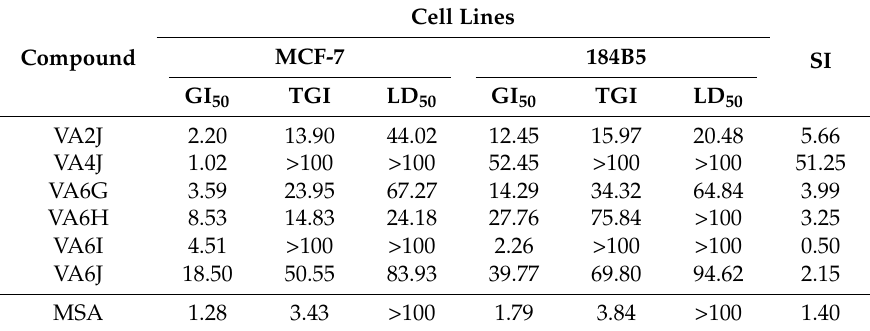
Table 1. Average values of GI 50 , TGI and LD 50 ( µ M) and calculated